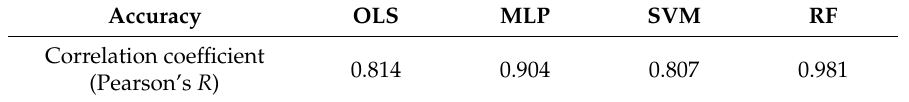
Table 6. Estimation results of non-commuting cycling activities by different